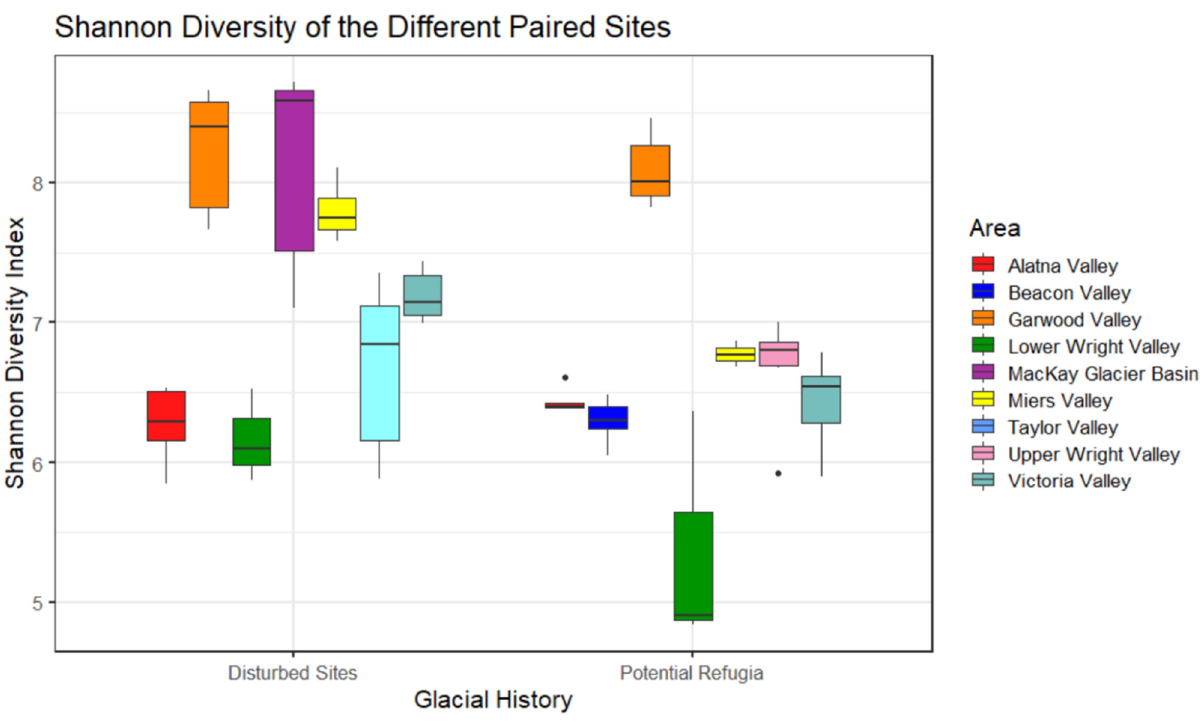
Figure 3. Shannon diversity of the different paired sites. Boxes are made up of all replicates from a single site and show the average diversity. Colors indicate valley basin of site location.